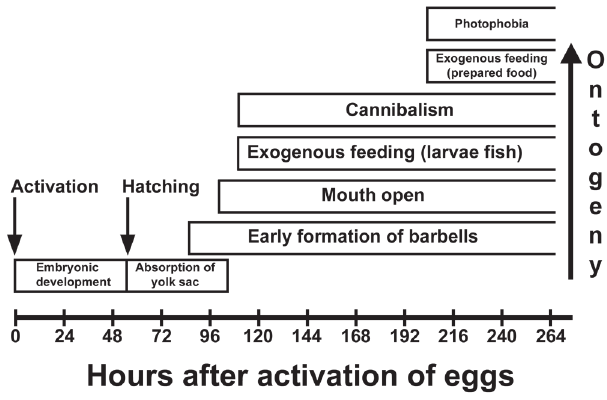
Fig. 6. Steindachneridion parahybae : major events during ontogeny of the surubim do Paraíba